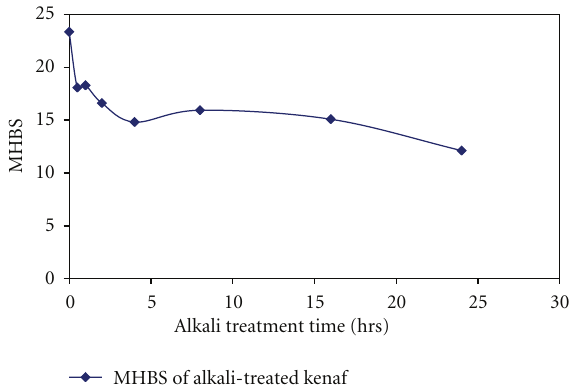
Figure 9: Carbon region of XPS spectra in untreated and alkali- treated kenaf